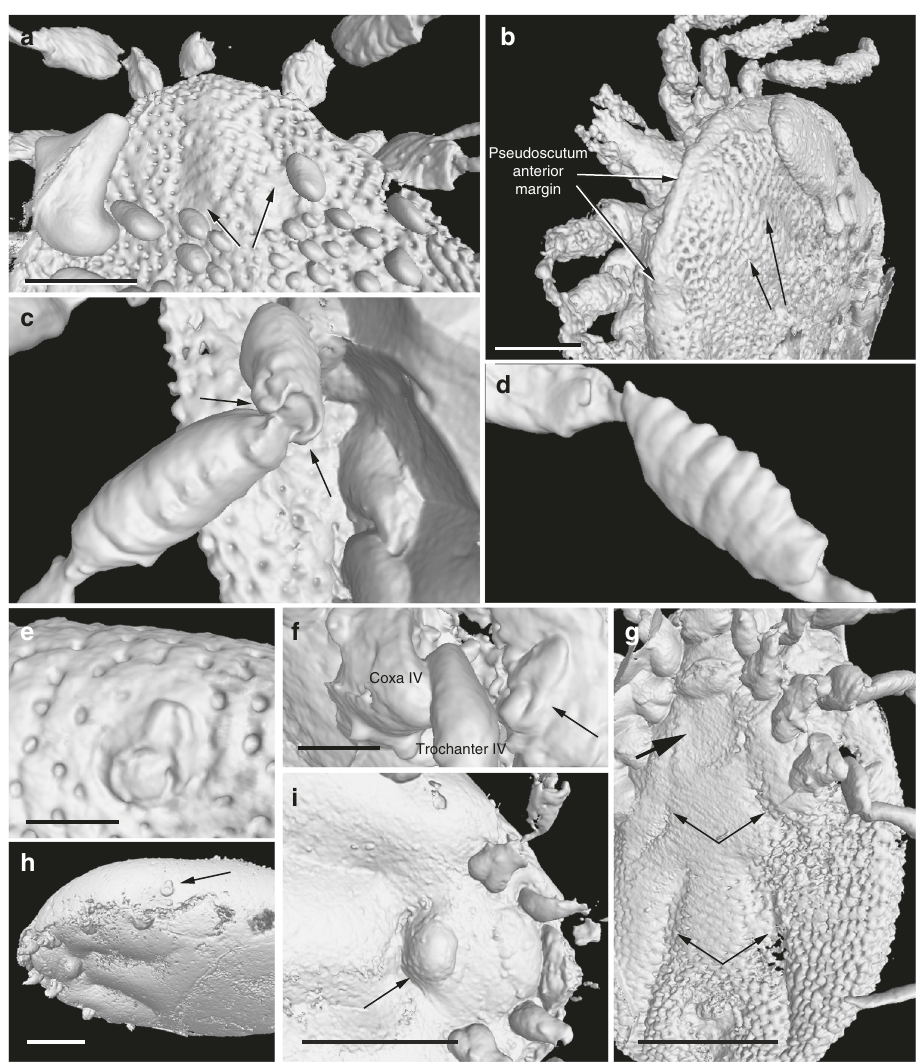
Fig. 5 CT-scan images showing some anatomical features of the new family Deinocrotonidae. Holotype (AMNH Bu-SA5a) ( a , c , d , f , g ); paratype male (AMNH Bu-SA5b) ( b , e ); engorged paratype female (CM 63001) ( h , i ). a Pseudoscutum showing the cervical grooves (arrows). Note the abundant bubbles (bottom). Scale bar, 0.5 mm. b Pseudoscutum in anterodorsal view showing its posteriorly broadened anterior margin and the cervical grooves (right arrows). Scale bar, 0.5 mm. c Trochanterofemoral articulation of the right leg III (femur length ca. 0.5 mm). Note the notch-like processes (arrows). d Ruf fl ed genual surface (genu length ca. 0.6 mm). e Right spiracle in frontal view. Scale bar, 0.2 mm. f Left spiracle in lateral view (arrow). Scale bar, 0.2 mm. g Post-genital, anteroventral depressed area (bold arrow) and genital groove medially divided in two sections (thin arrows). Scale bar, 1 mm. h Habitus showing the deformation of the body and the completely stretched integument due to engorgement (arrow indicates the spiracle). Scale bar, 1 mm. i Detail of the ventral surface showing the genital aperture extruded as a rounded protuberance (arrow). Scale bar, 1